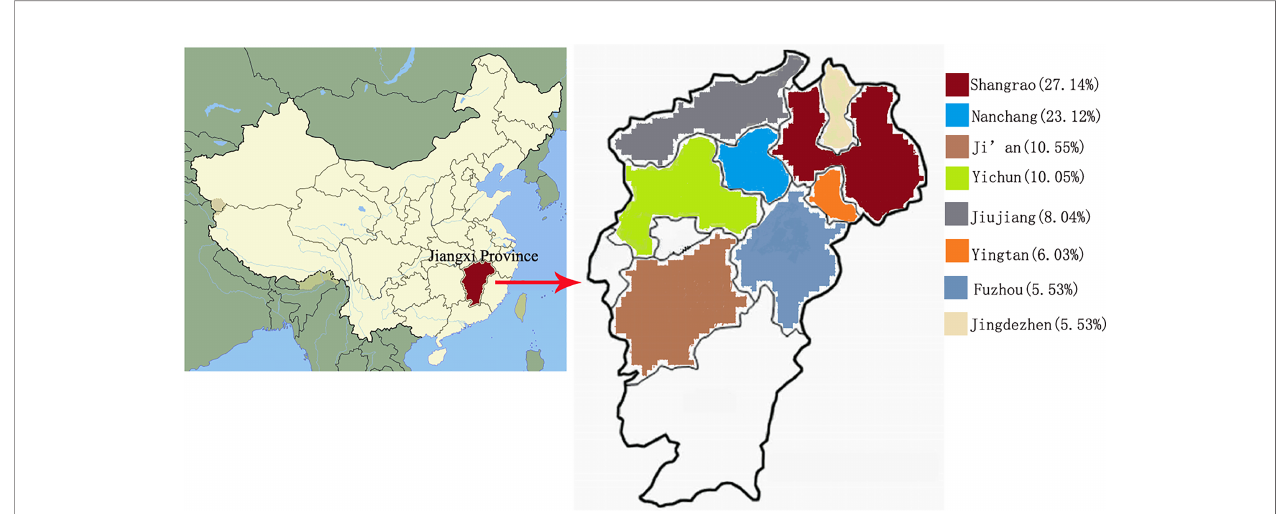
FIGURE 1 | Surveillance point, Jiangxi Province and patient distribution in various